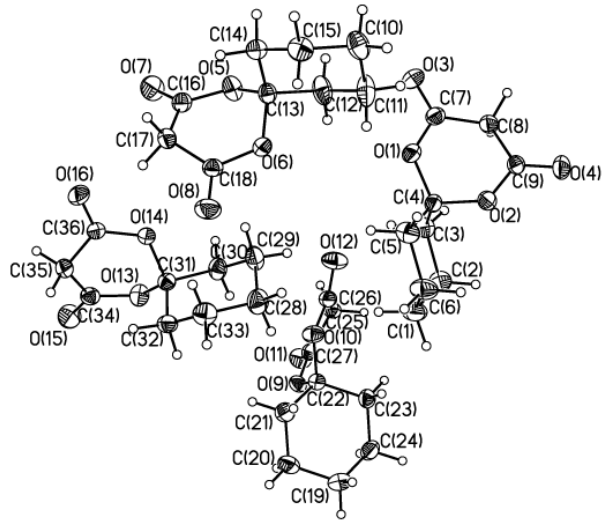
Table 1. Data collection and handling.